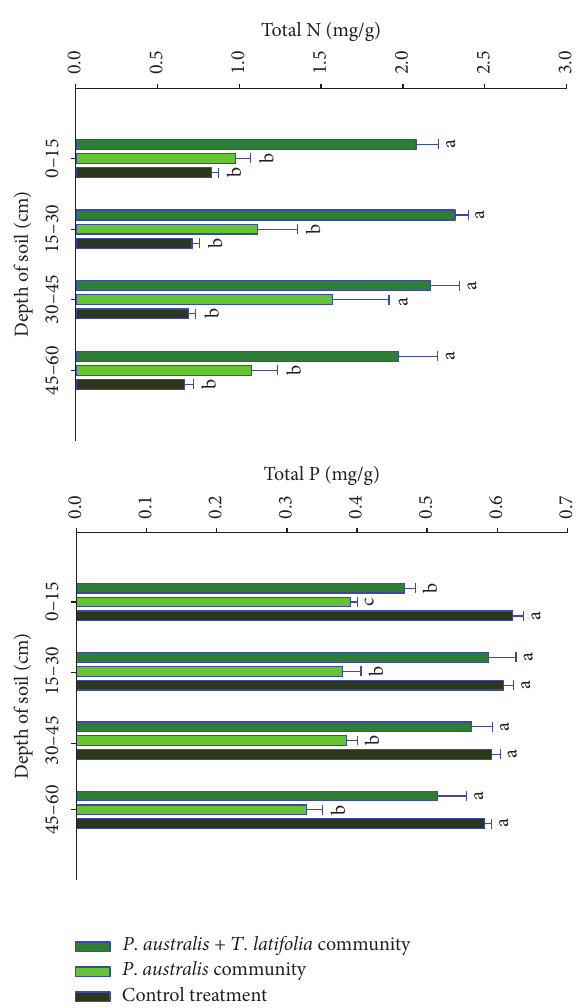
Figure 1: Concentrations of TN and TP in different depths of soil in experimental site. Different lowercase letters indicate significant difference among TN and TP contents of soil ( 𝑃 < 0.05 ). Values are mean + 1